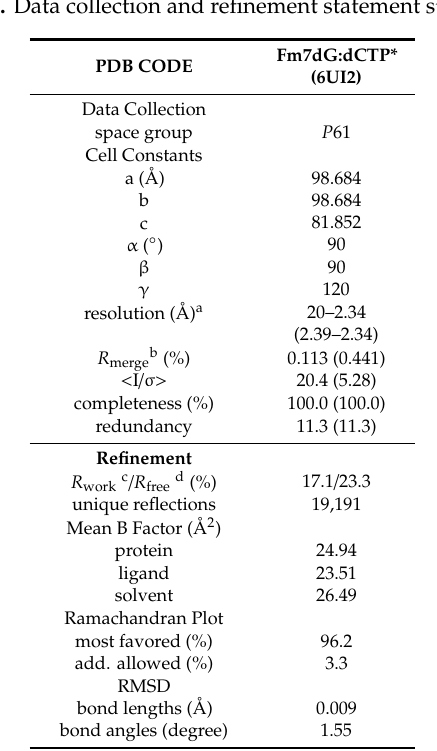
Figure 3. Overall conformation of the pol η -Fm7dG:dCTP* complex structure. ( Α ) The ternary complex structure of pol η bound to Fm7dG and the incoming nonhydrolyzable dCTP analog. The palm, thumb, finger, and little finger domains are shown in orange, green, cyan, and yellow, respectively. The flexible Arg61–Trp64 loop is shown in blue. The primer strand is colored in white and the template strand in gray. The active site Mg 2+ ions are shown in green spheres. ( Β ) Superposition of the pol η -Fm7dG:dCTP* and the pol η -dG:dCTP* (light pink, PDB ID: 4O3N [41]) structures. Table 2. Data collection and refinement statement statistics.